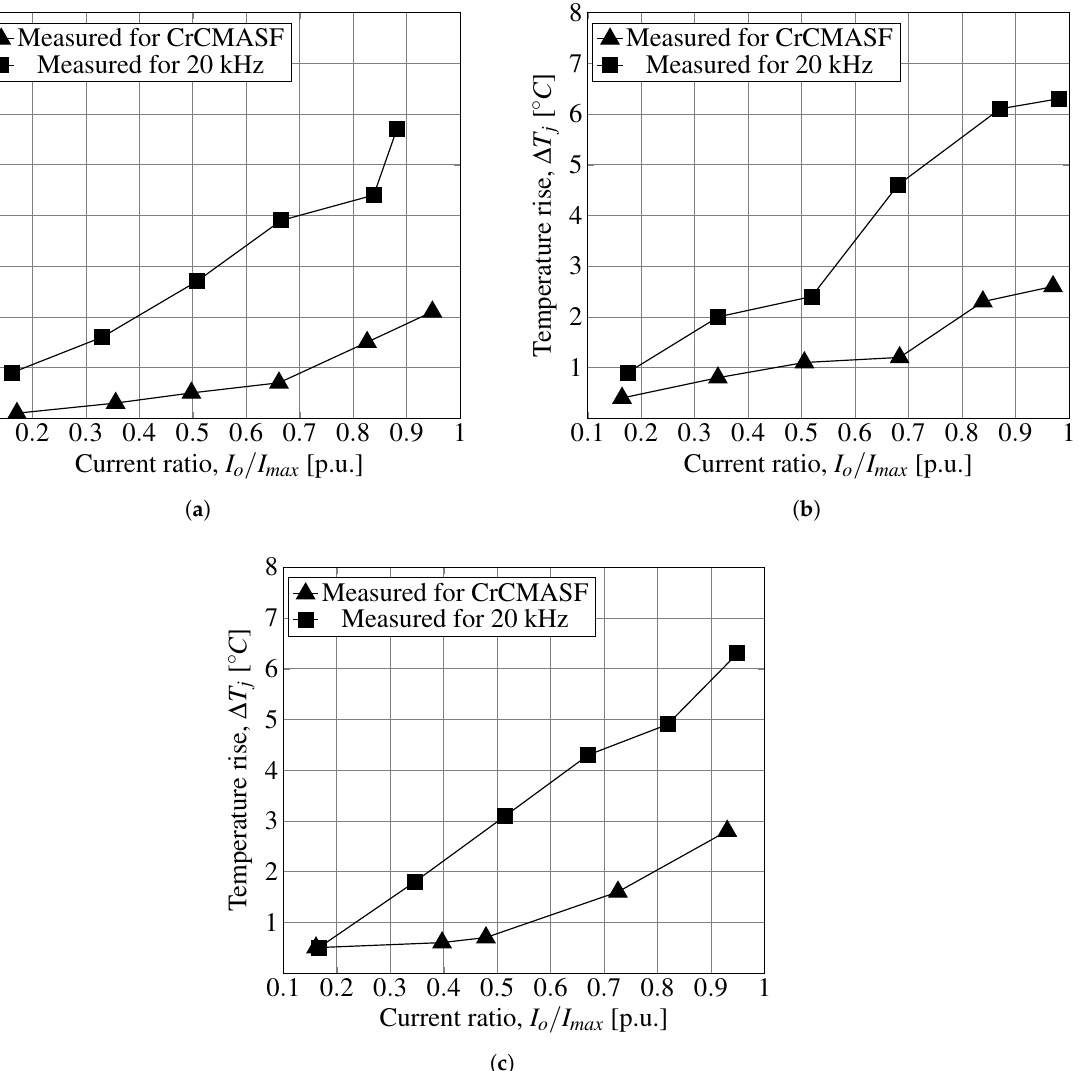
Figure 15. Junction temperature of switch 1 for different duty cycles: ( a ) junction temperature for a duty cycle of 0.95; ( b ) junction temperature for a duty cycle of 0.9; ( c ) junction temperature for a duty cycle of